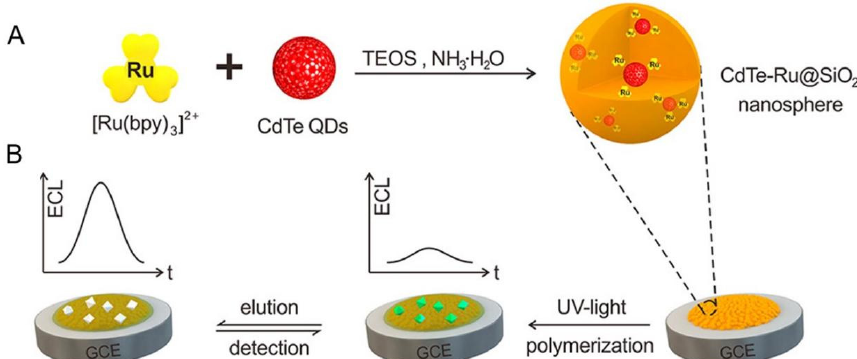
Figure 5. Schematic illustration of the synthesis of CdTeRu@SiO 2 nanospheres ( A ) and fabrication of the MIP-ECL platform for mycotoxin detection ( B ). Reprinted from [75] with permission from the American Chemical Society.